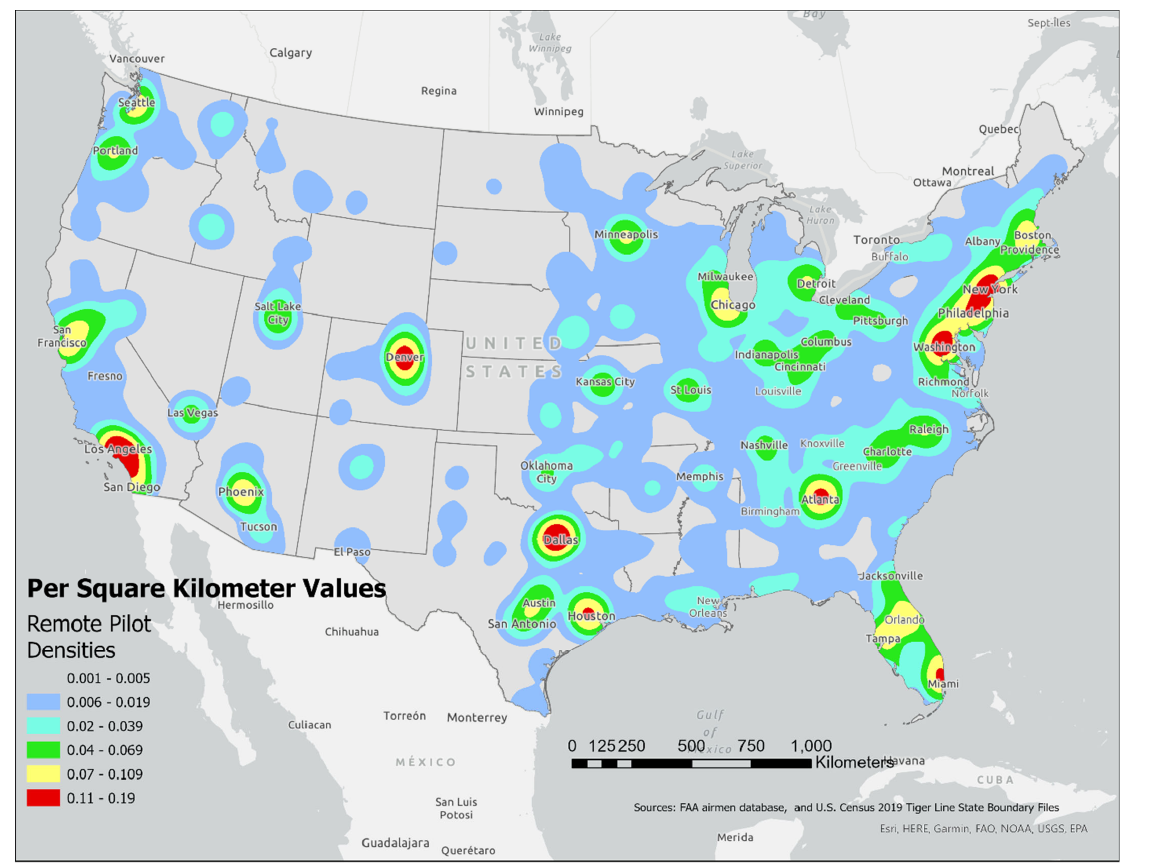
Figure 7. Kernel Density of FAA Registered Remote Pilots.